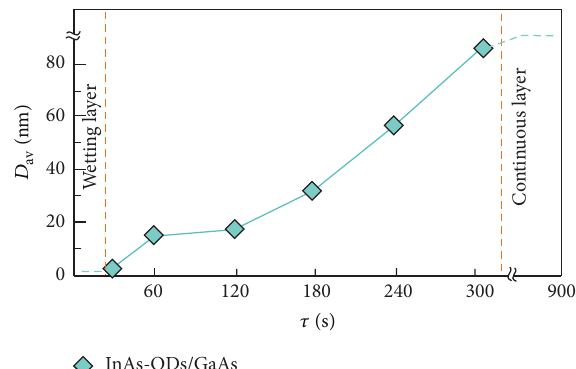
Figure 4: Time chart of the nanoisland transformation during ion- beam